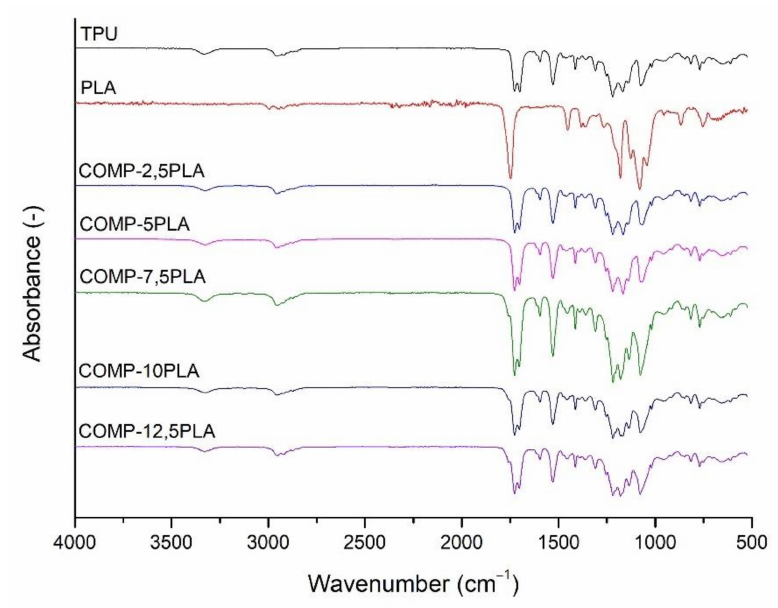
Figure 2. FTIR spectra of the prepared